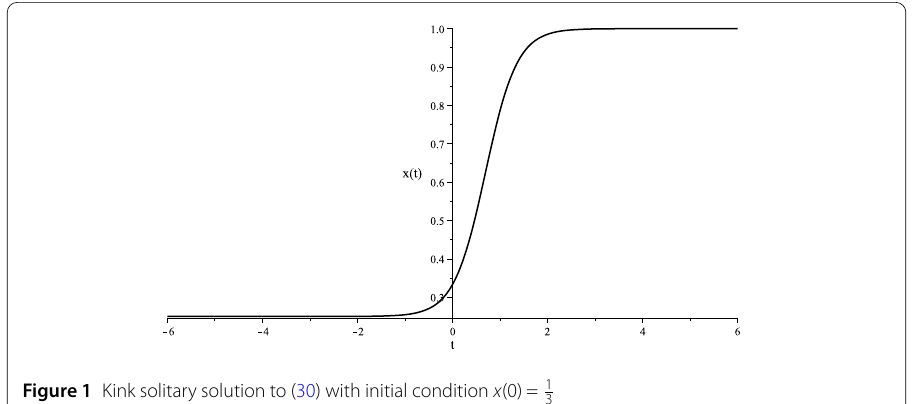
Figure 1 Kink solitary solution to (30) with initial condition x (0) = 1